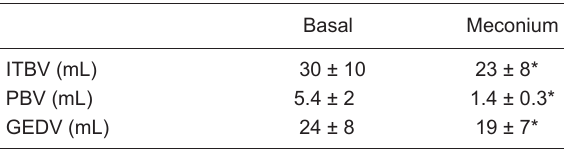
Table 1. Effect of meconium on circulating thoracic blood of new - born piglets (calculated parameters).